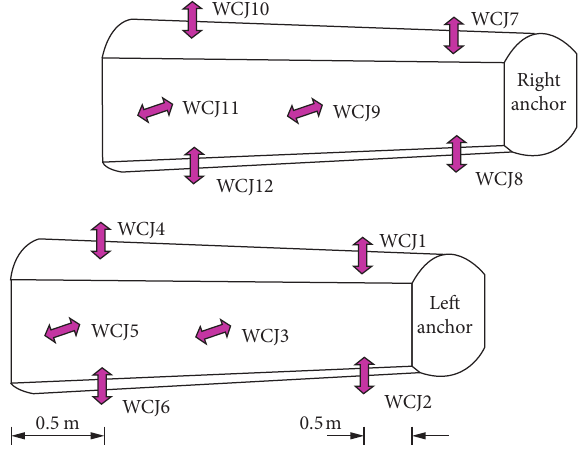
Figure 15: Dislocation meters around the two model